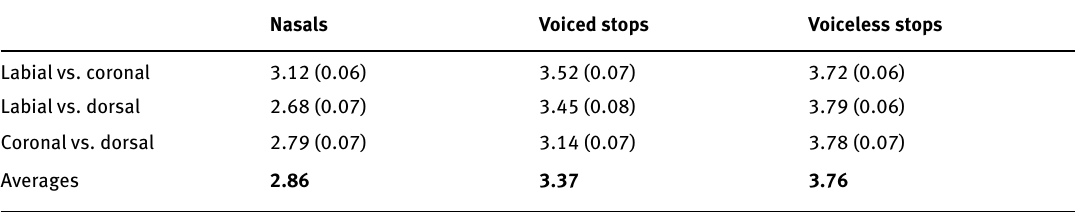
Table 2: The average similarity ratings in Experiment II (margins of errors for 95% confidence